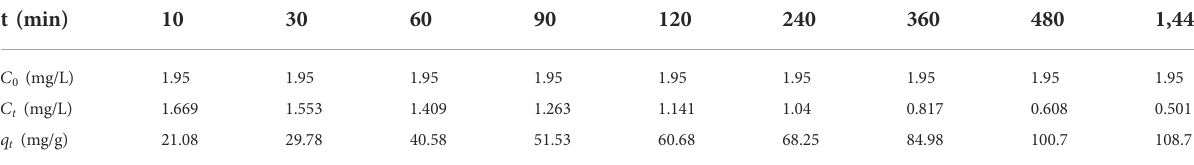
TABLE 3 The adsorption capacity of phosphorus on ceramsite loaded with nano-iron by different adsorption